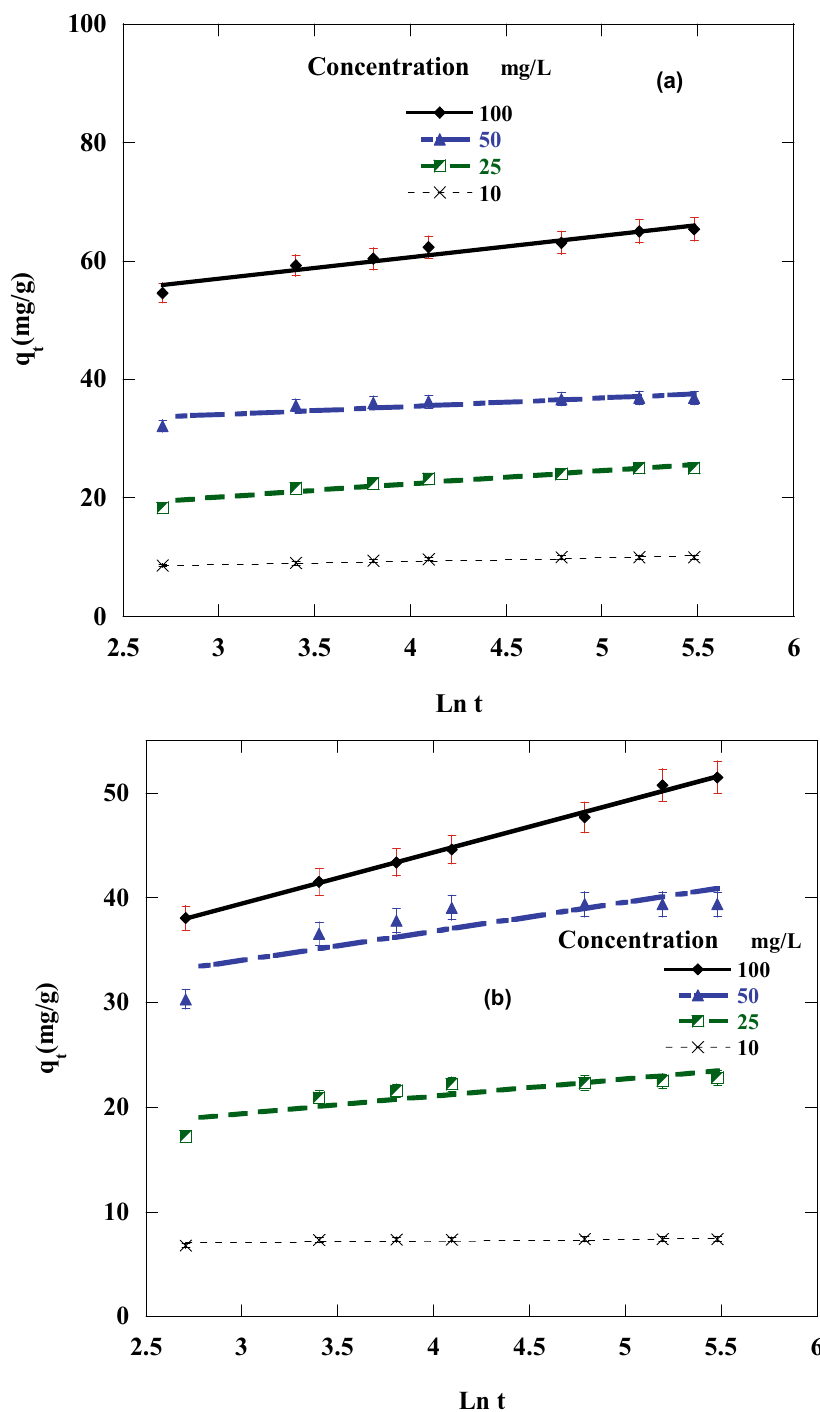
Figure 13. Plots for evaluating Elovich kinetic model for sorption of Disperse red 60 dye at 20 °C and pH 6 by 50 mg of: ( a ) CF, ( b )